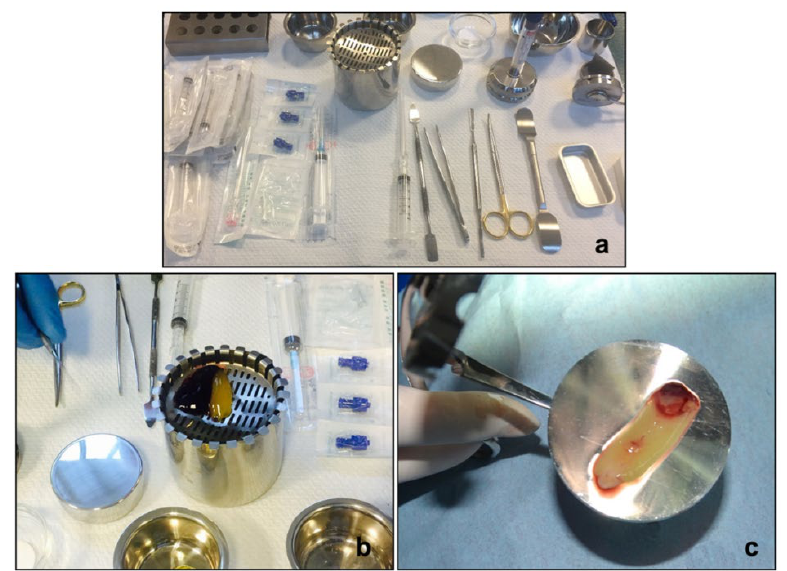
Figure 3. Concentrated growth factor (CGF) preparation. ( a ) Surgical instruments for CGF prepa- ration; ( b ) CGF plus melatonin and ( c ) fibrin buffy coat pressed in a membrane.